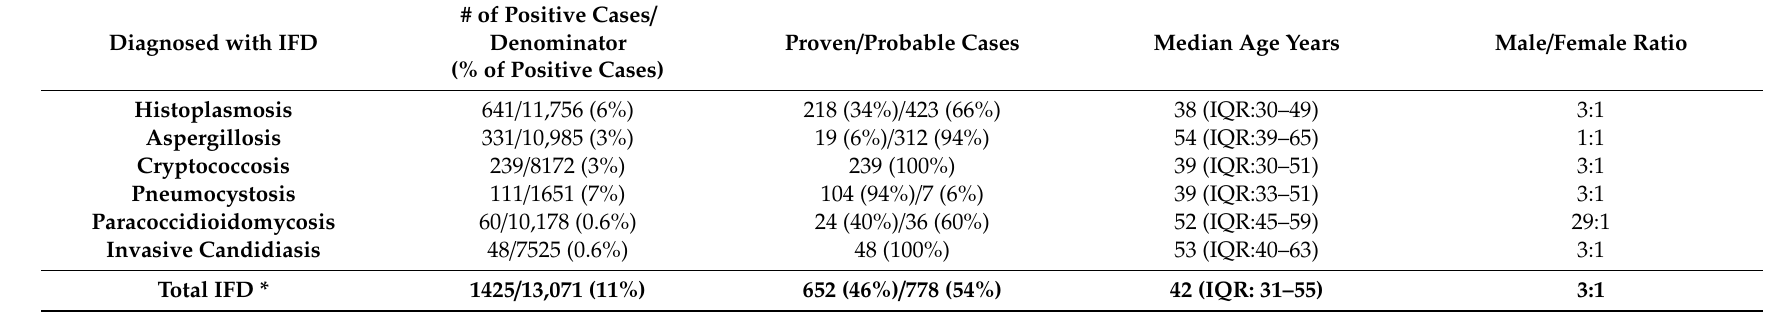
Table 1. Patients diagnosed with invasive fungal disease